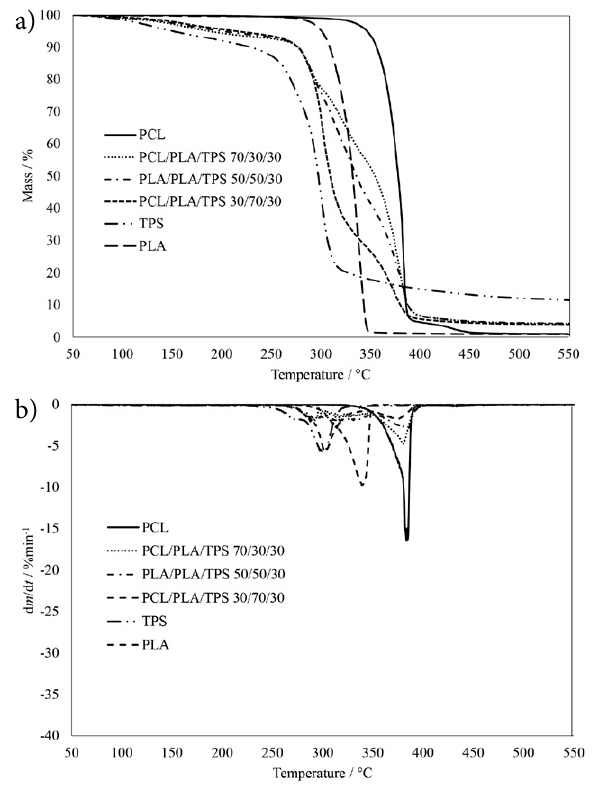
Fig. 3. TG (a) and DTG (b) curves of the thermal degradation of the PCL/PLA/TPS blends at the heating rate of 2.5 °Cmin −1 .